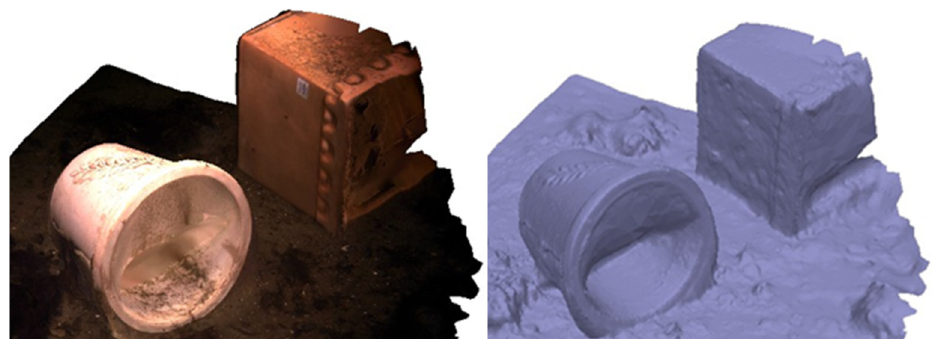
Figure 4. Reconstructed pottery vessels with color mapping ( left ) and 3D representation ( right ), both obtained from visual odometry.